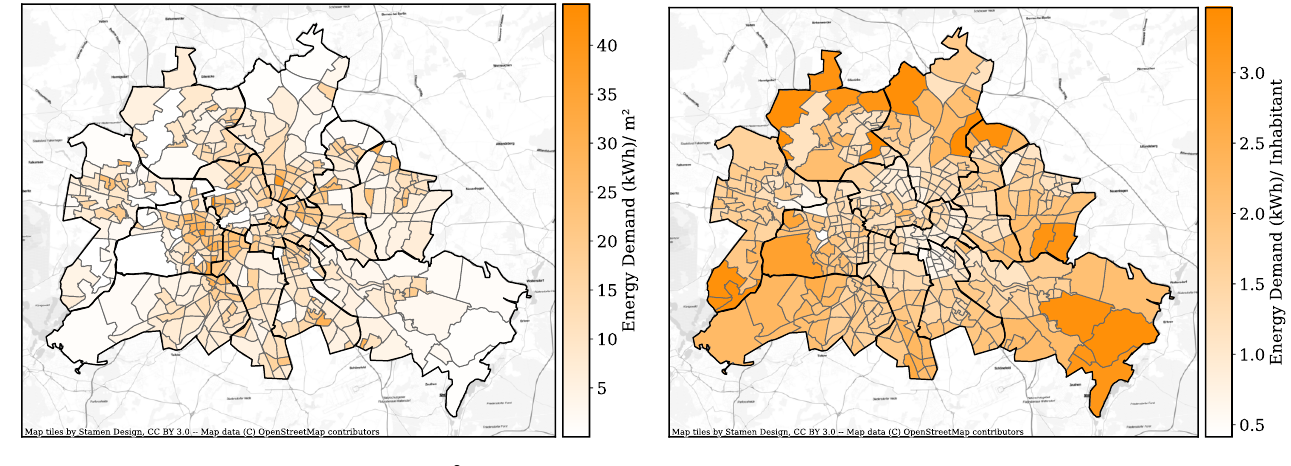
Figure 12. Spatial distribution of the BEV charging energy demand for a working day (Monday–Thursday) normalised to the size and the inhabitants in the Berlin